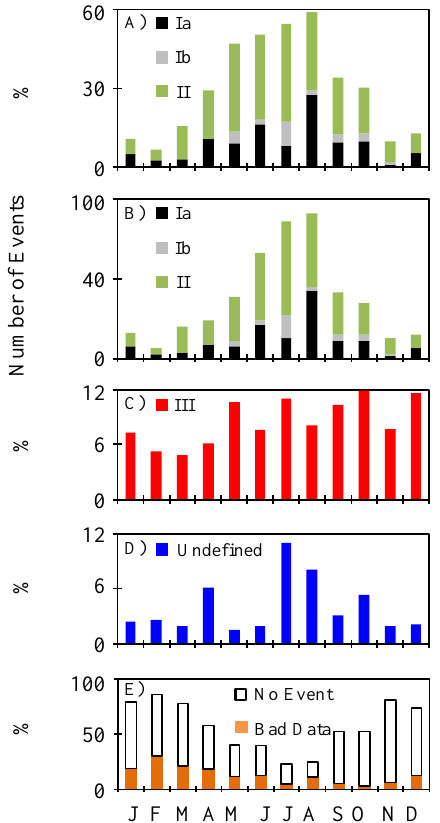
Fig. 6. (A , and C – E ) Number of days per month (%) in which each event (Ia, Ib, II, III, undefined, non-event and bad data) was observed. (B) Accumulated number of days (for the period 2008– 2012) in which an event (Ia, Ib and II) was observed in each